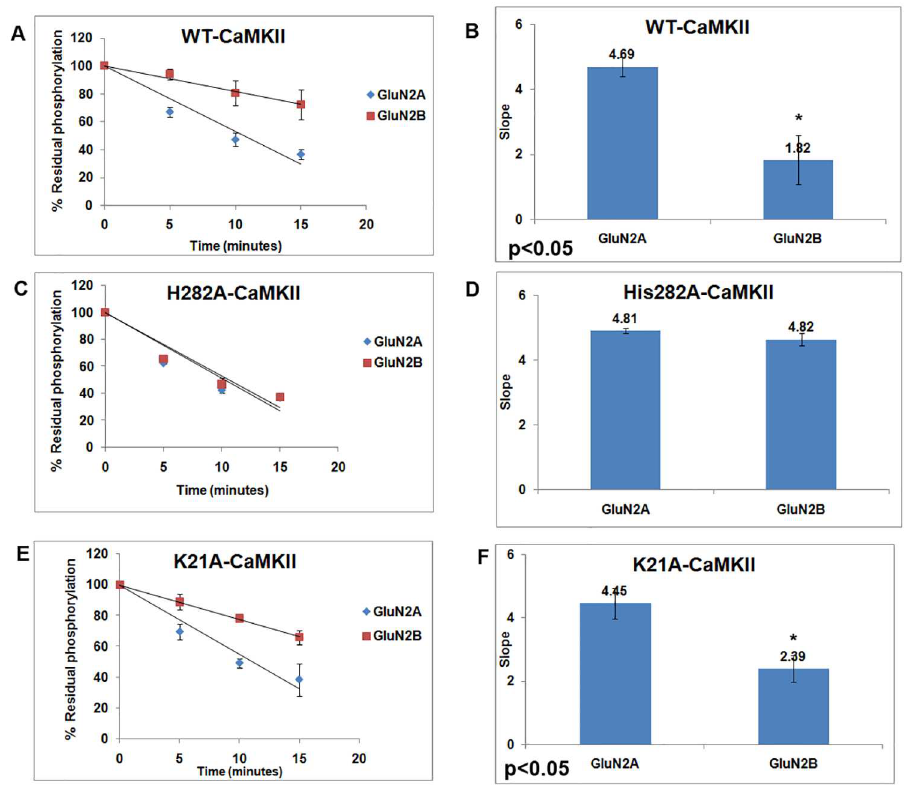
Fig 4. Comparison of the effectof GluN2Bon the ratesof dephosphorylationof WT, H282A and K21A forms of α -CaMKII. WT and mutants,H282A and K21A, of α -CaMKII expressed with N-terminal GFP fusions in HEK-293cells were used for the experiments. A, C and E: The timecourse of dephosphorylationof WT, H282A and K21A in presenceof GST-S1303A-GluN2Bor GST-S1291A-GluN2Aat 5, 10 and 15 minutes. PhosphorylationintensitywithoutPP1 at 0 timewas taken as 100%.The values plottedwere fromthe densitometricdata of autoradiographic imagesas shown in S5 Fig, fromthreeexperiments. B, D and F: The slope values of the plots of the time course of dephosphorylationin presenceof GluN2B and GluN2A sequences are presentedas the bar graphs. (For B and F, p < 0.05 in a two-tailedstudent’s t-test)